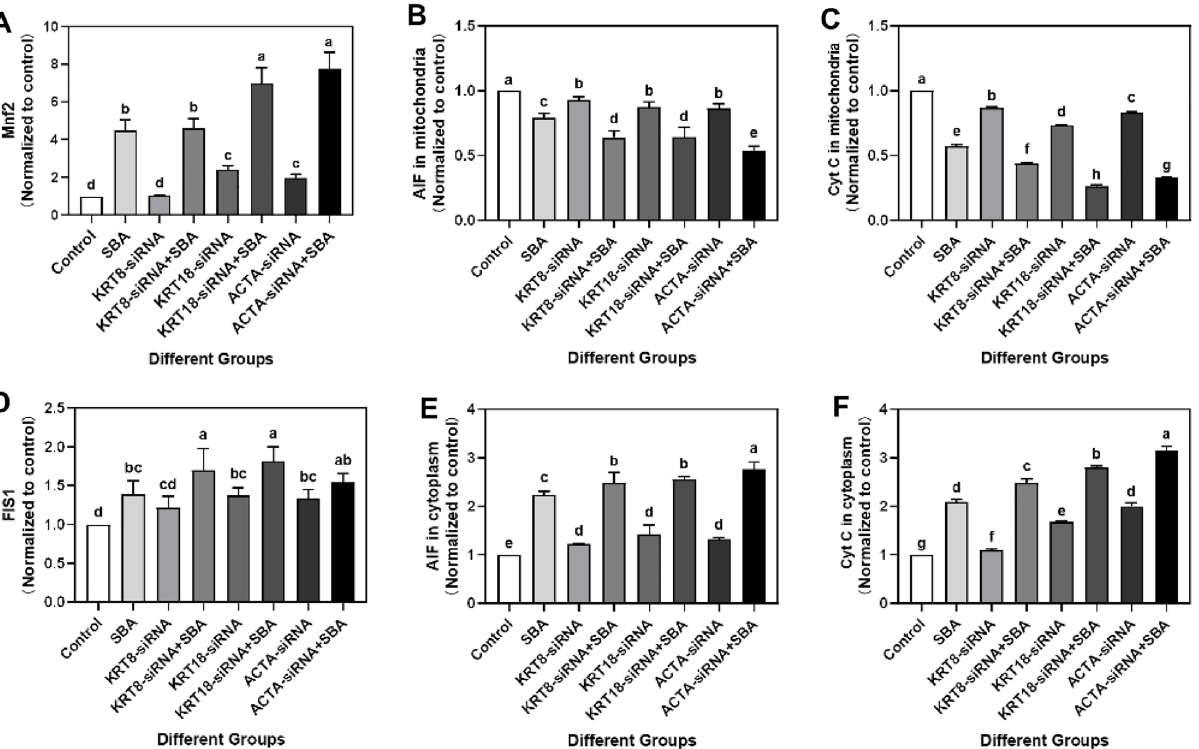
Figure 10. ( A – F ). Analysis of the protein expression of mitochondrial structure and function in different treatment groups. The protein expressions in different treatments were obtained from the western blot represented. ( A ) Protein expression of Mnf2; ( B ) Protein expression of AIF in mitochondria; ( C ) Protein expression of CytC in mitochondria; ( D ) Protein expression of FIS1; ( E ) Protein expression of CytC in the cytoplasm; ( F ) Protein expression of AIF in the cytoplasm. Data were analyzed using Bandscan software. Each column represents the mean ± SEM of three independent experiments. Different lowercase letters indicate the significance of differences between different treatment groups ( p < 0.05).